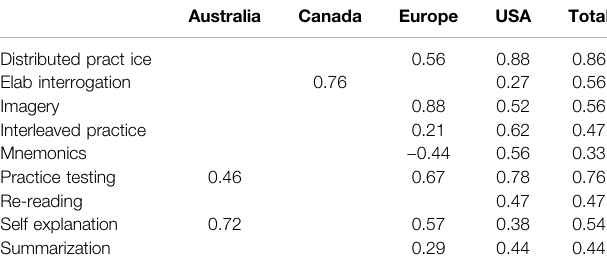
TABLE 4 | Effect size moderated by Country of fi rst